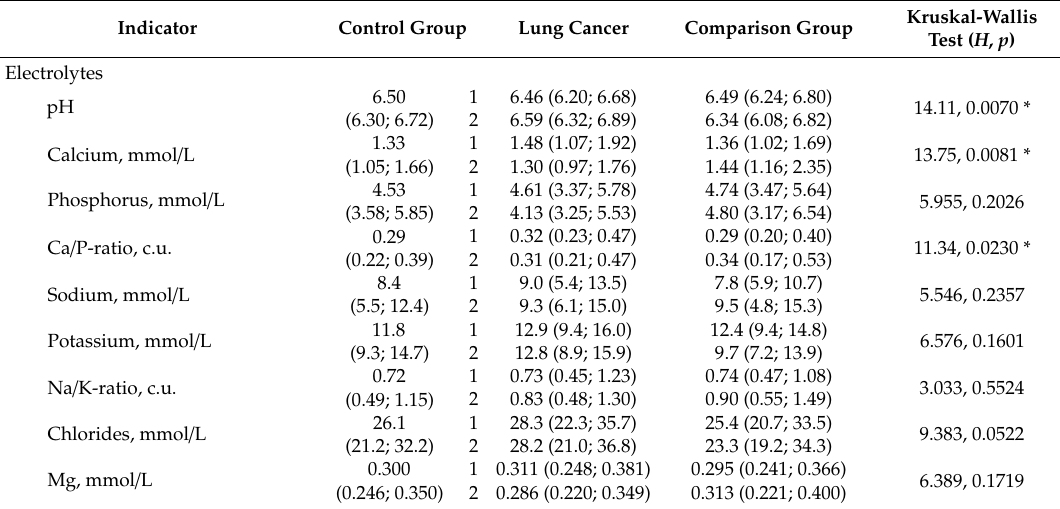
Table 4. Biochemical markers of saliva in patients with lung cancer, noncancerous pathologies of the lung and control